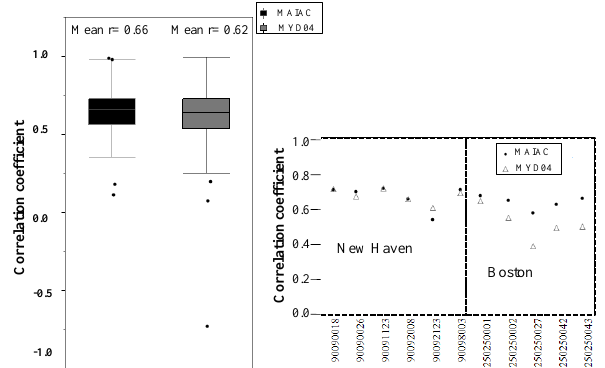
Fig. 3. Left: correlation coefficient between PM 2 . 5 and AOD by Figure 3. EPA site location for 85 sites (years 2002–2008). Right: correlation coefficient between PM 2 . 5 and AOD for two urban locations: New Haven area and Boston.